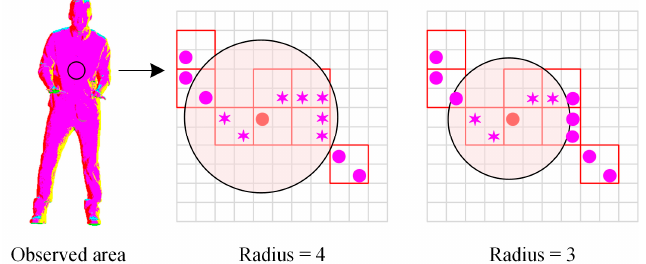
Figure 4. Local neighborhood information obtained by various radii. Note that the searched neighbors are signaled with asterisks.